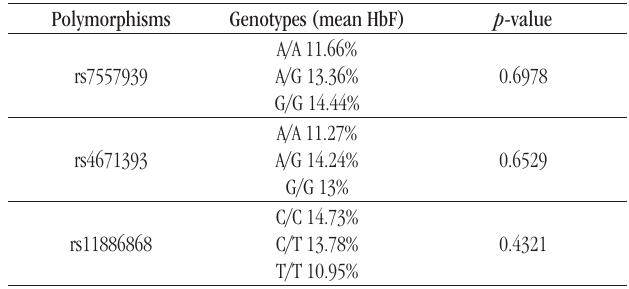
The p -value was obtained by one-way analysis of variance test (Anova). Anova: analysis of variance.